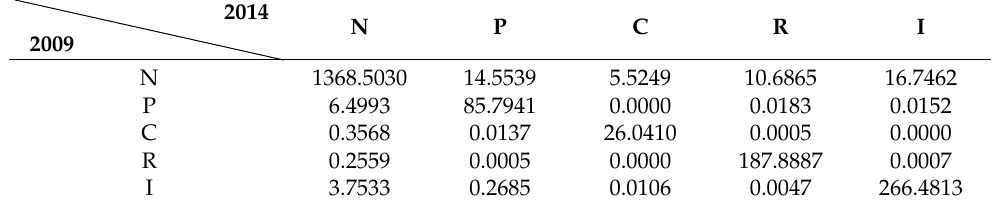
Table 2. Total conversion area (km 2 ) of different land use types in Shenzhen from 2009 to